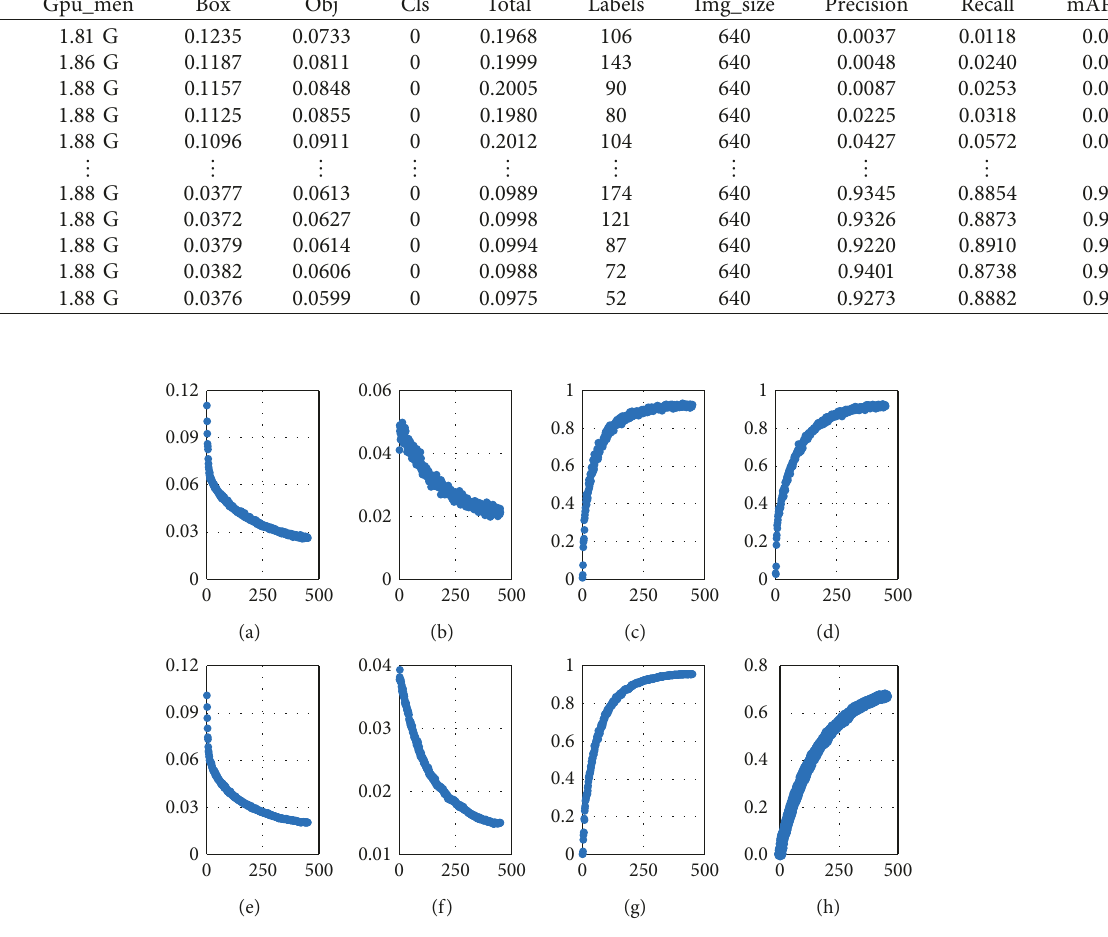
Figure 5: YOLO v3 training result graph. (a) Box (b) objectness, (c) precision, (d) recall, (e) Val Box, (f) Val Objectness, (g) mPA@0.5, and (h) mPA@0.5:0.95.